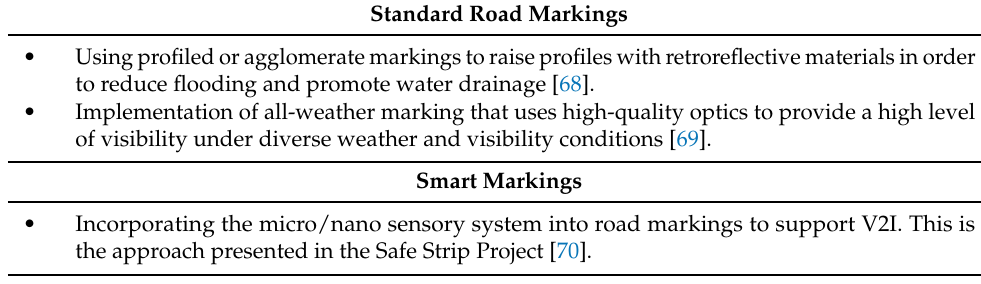
Table 8. Advances in lane detection.